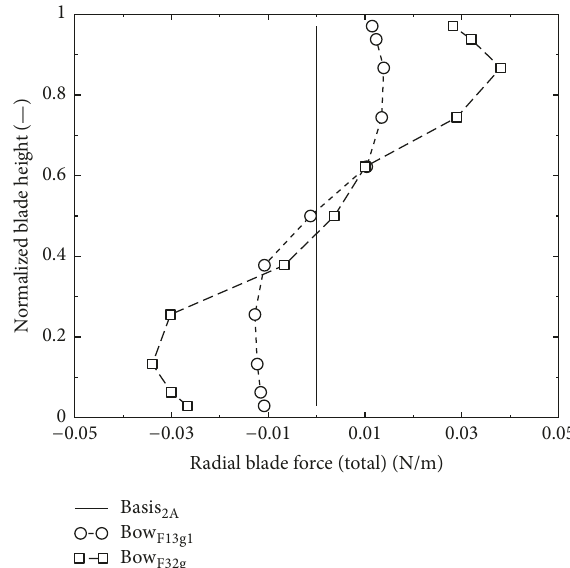
Figure 8: Distributions of the resultant radial blade force for the guide vanes over the blade